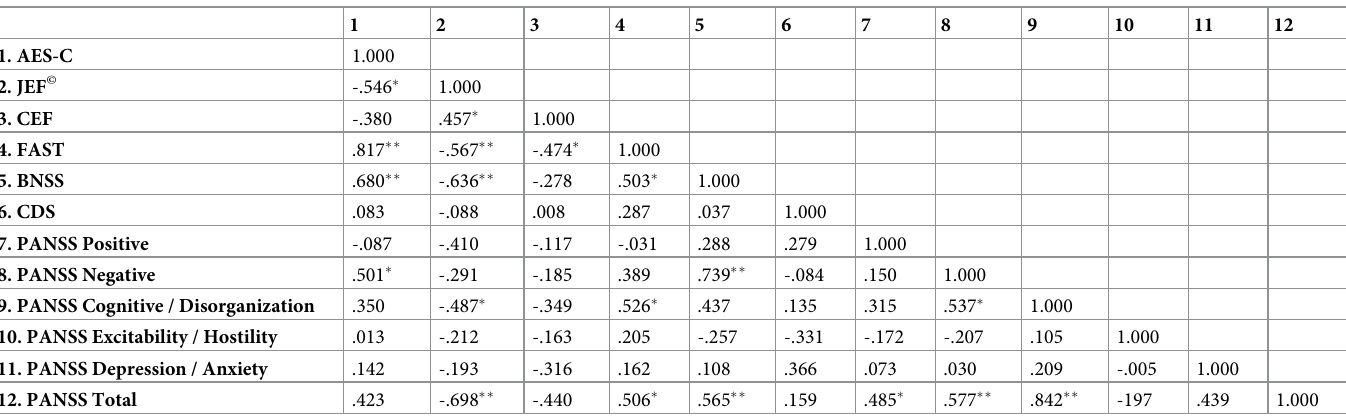
Table 2. Correlations among measures of schizophrenia patients.